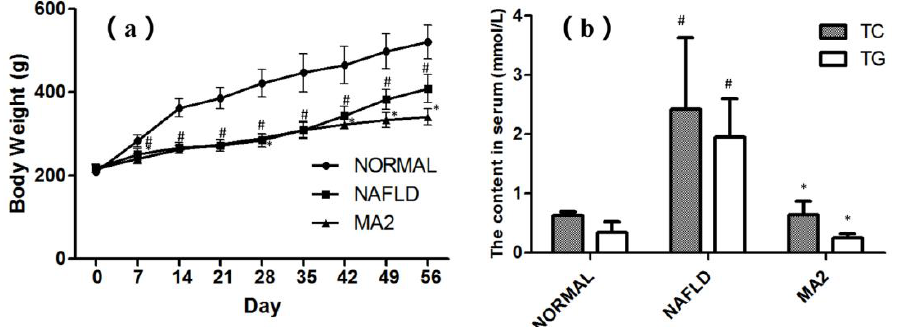
Figure 1. Effects of Lactobacillus plantrum MA2 on body weight and lipid metabolism in NAFLD rats. ( a ) Boday weight of the rats in different group from Day 0 to 56, ( b ) the content of TC and TG in serum at Day 56, (# indicates p < 0.05 compared with the normal group; * indicates p < 0.05 compared with the NAFLD group. NORMAL: normal group, NAFLD: non-alcoholic fatty liver disease, MA2: L. plantarum MA2 treatment group).